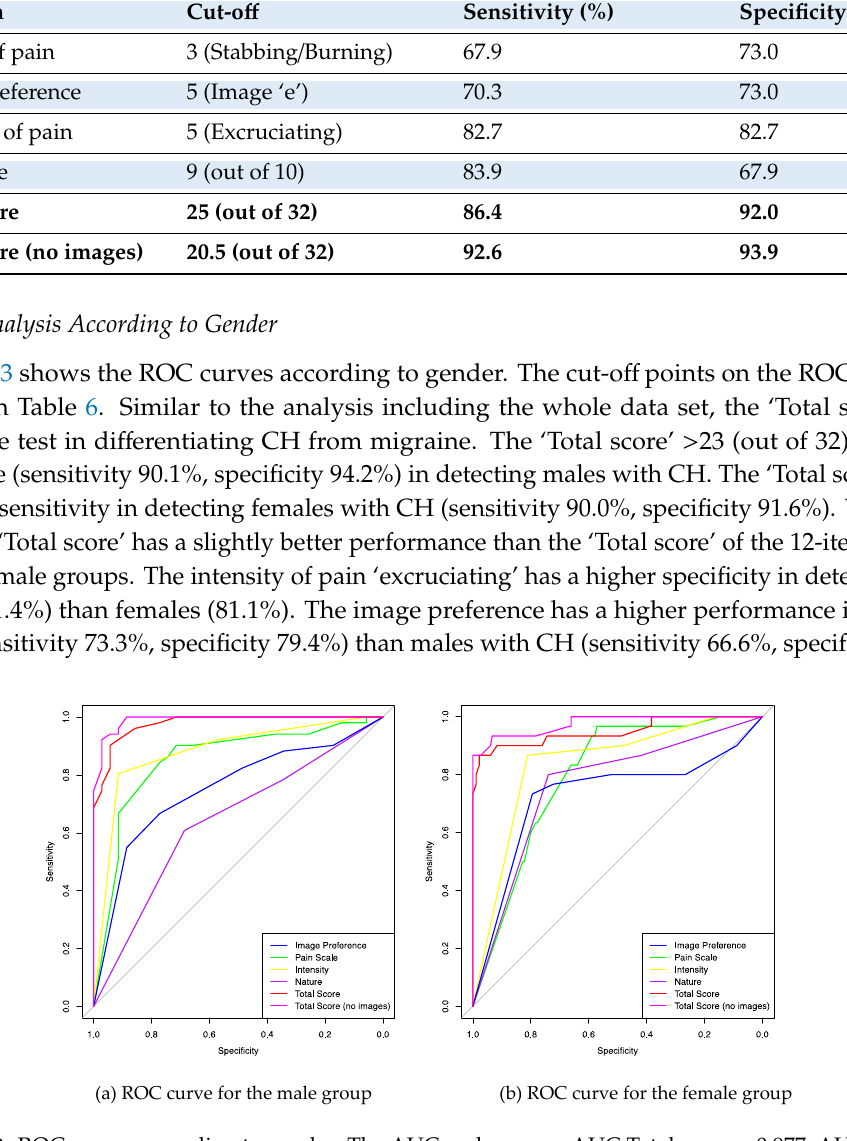
Table 5. Cut-o ff points on the ROC curves for whole data set.